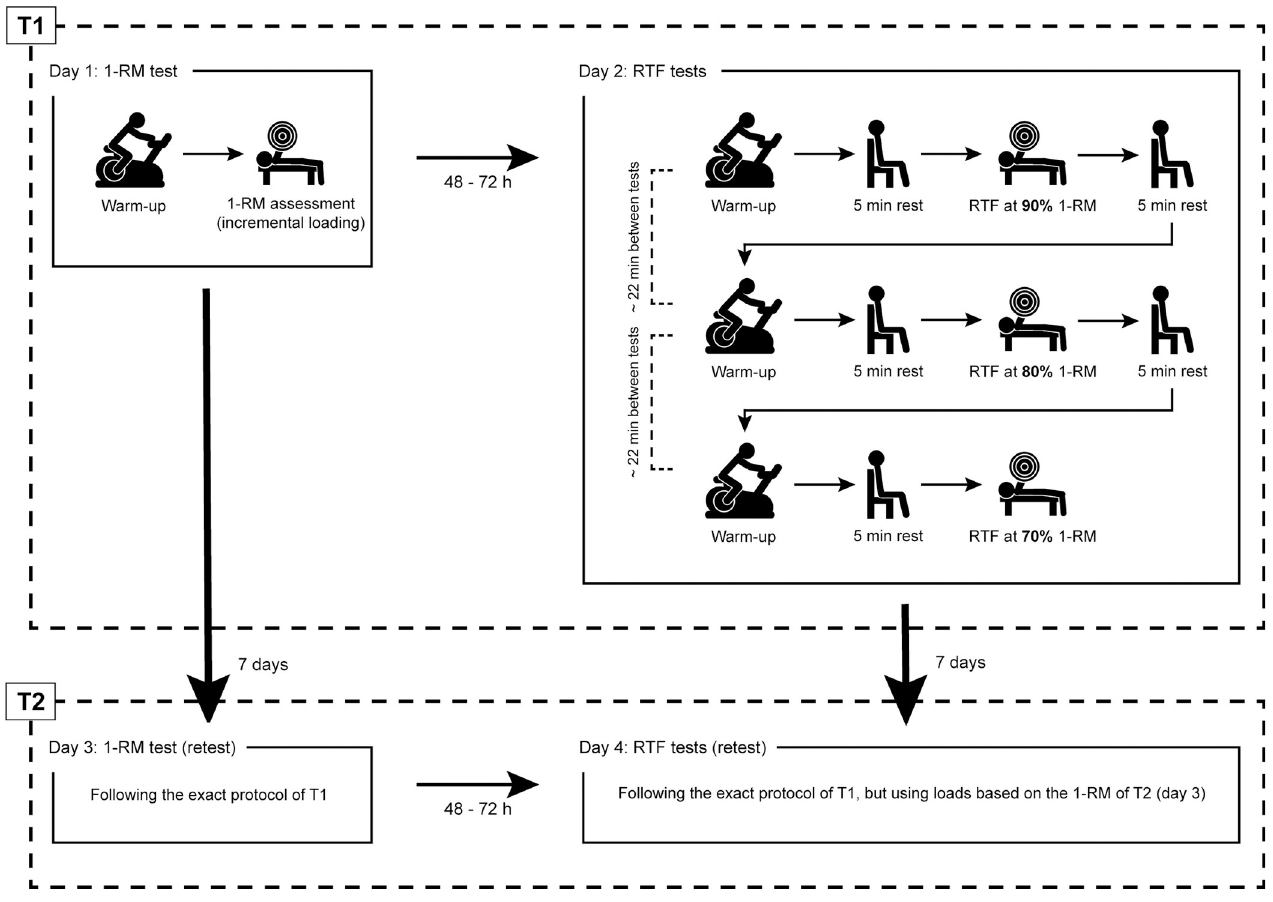
Fig 1. Experimental design. 1-RM, one-repetition maximum; RTF, repetitions performed to momentary failure.